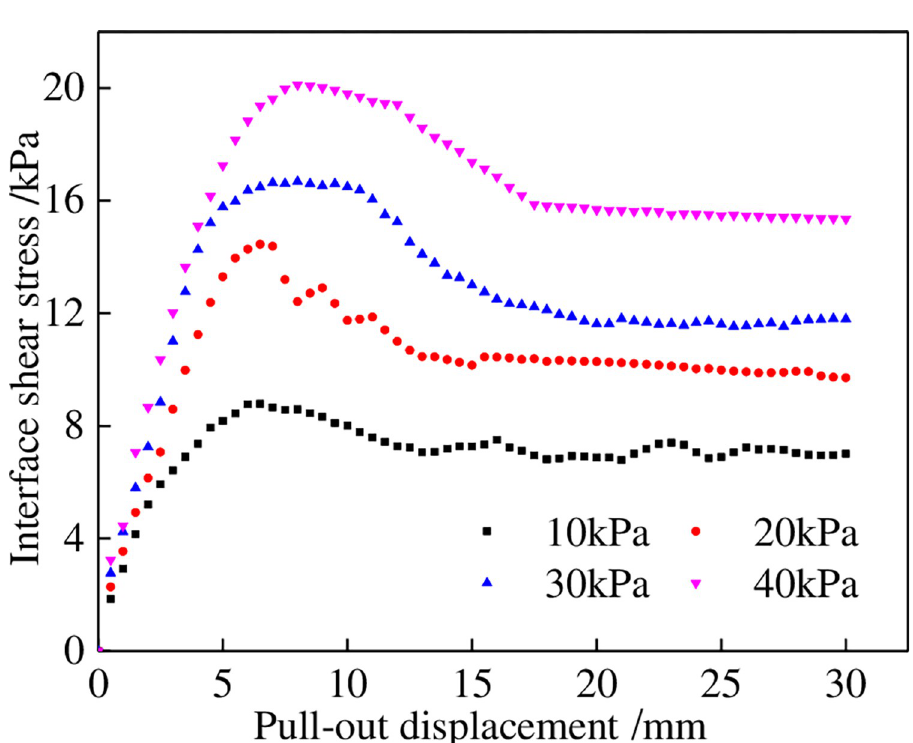
Fig 3. Pull-out test results between geotextiles and